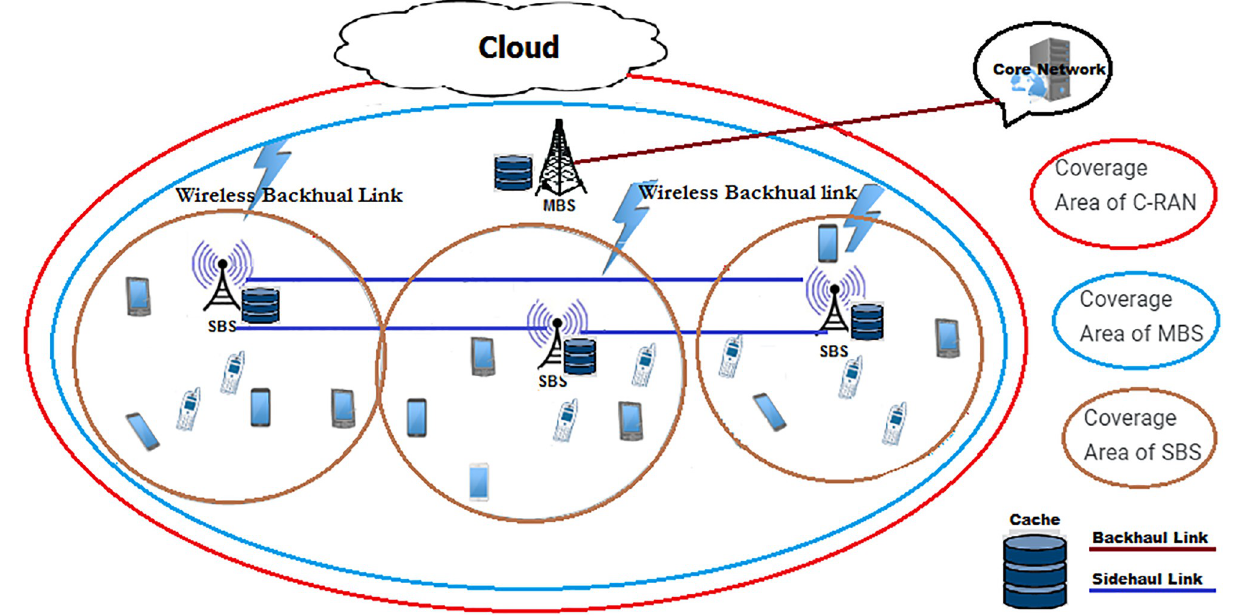
Fig 1. System model of distributed caching in B5G cellular